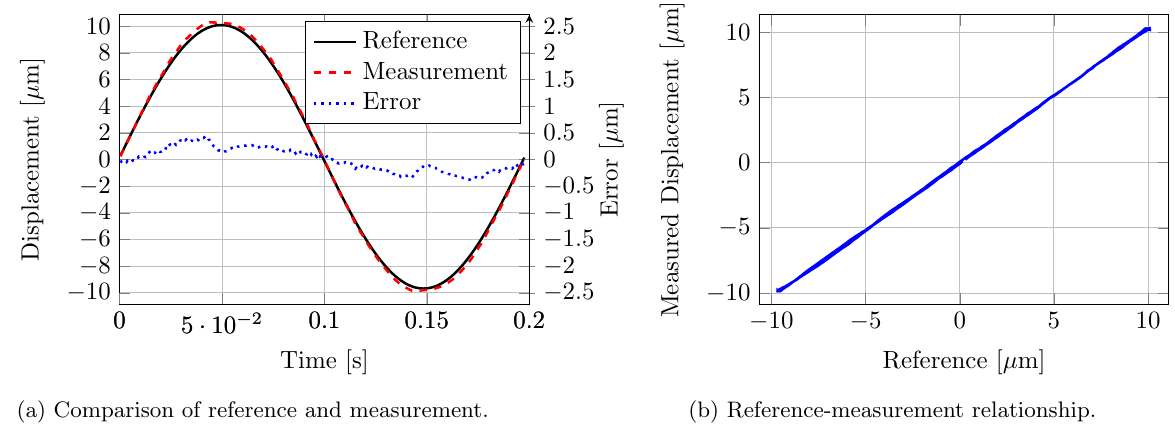
Figure 12: Best performance of Preisach model hysteresis compensation with discretization level n h = 100.